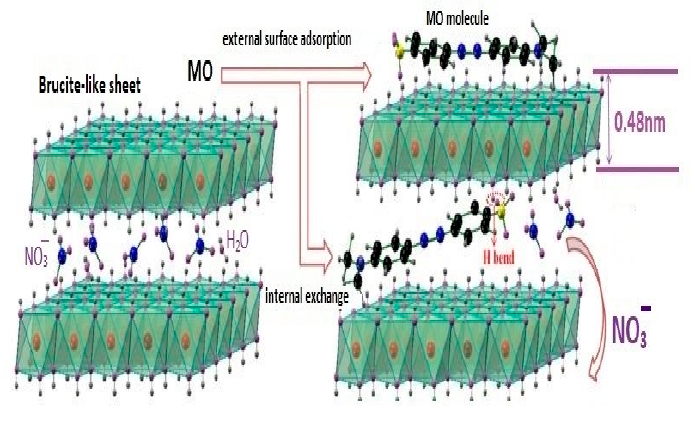
Figure 3. The LDH structure and methyl orange adsorbed between the layers.